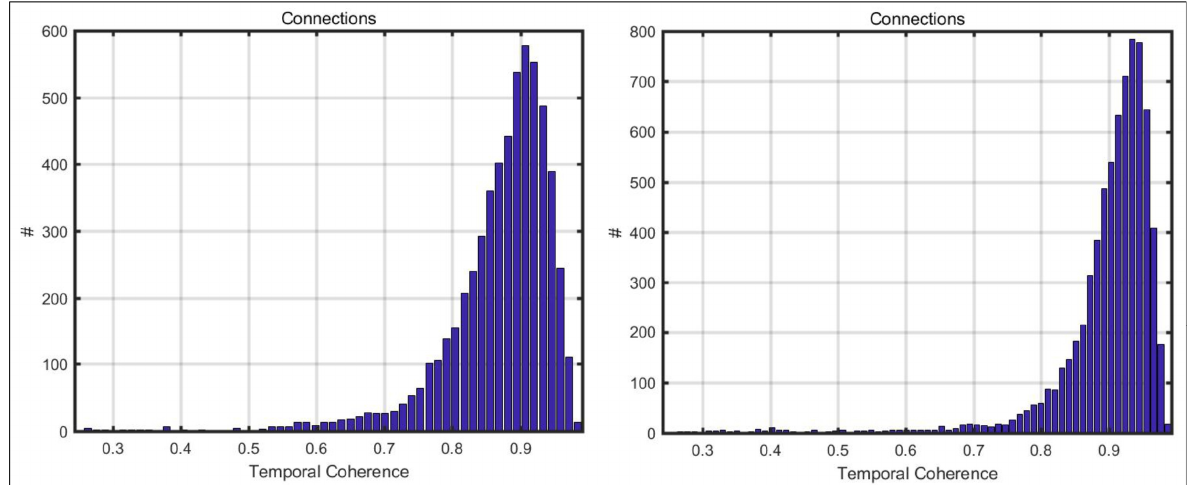
Figure 7. The graphs between the connections and temporal coherence for descending track on the right and ascending track data on the left side.